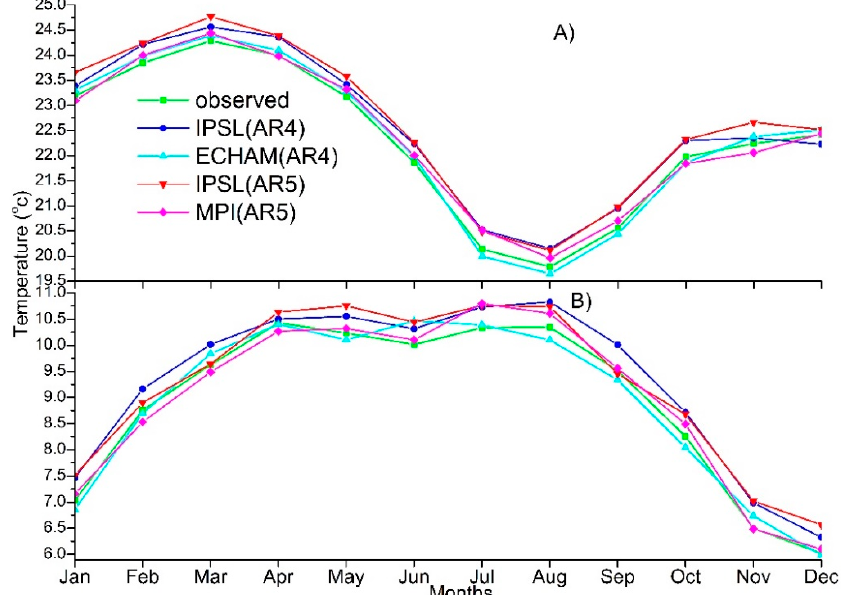
Figure 6. Observed monthly temperature (1990–2011) and General Circulation Models (GCMs) baseline (1971–2000): ( A ) the maximum temperature, and ( B ) the minimum temperature.